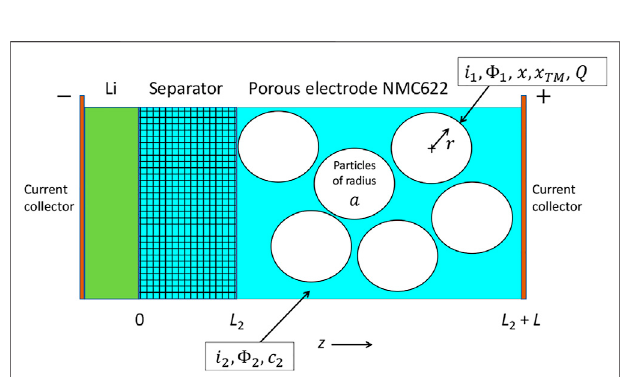
FIGURE 5 | Estimated open-circuit potential U for various cycles N . Symbols represent the potential after 15-min of open circuit for the data of Figure 2 .